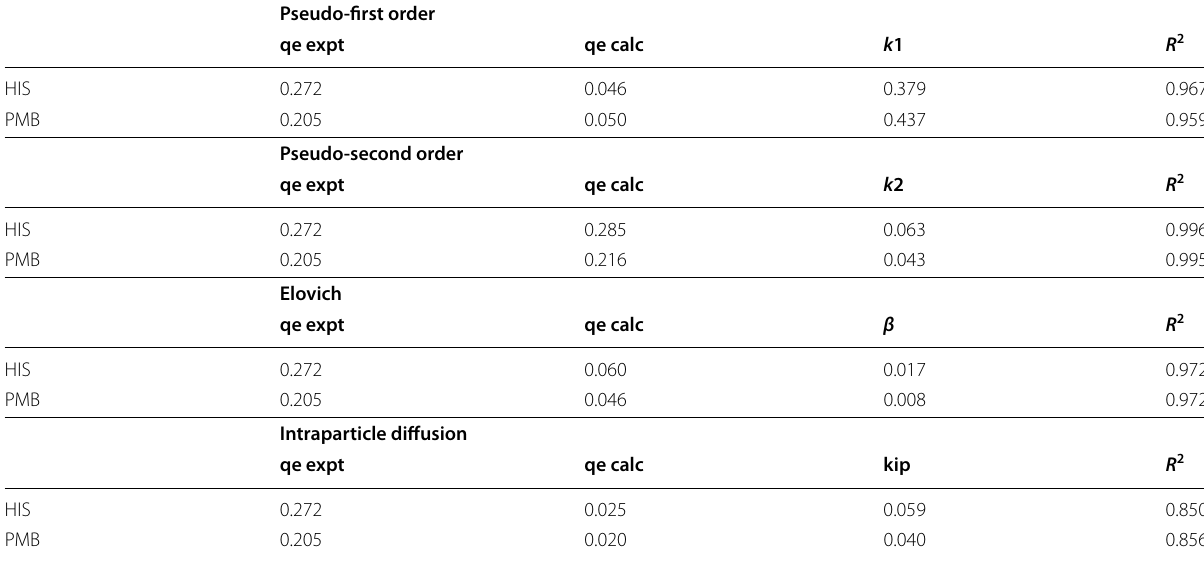
Table 3 Experimental kinetics